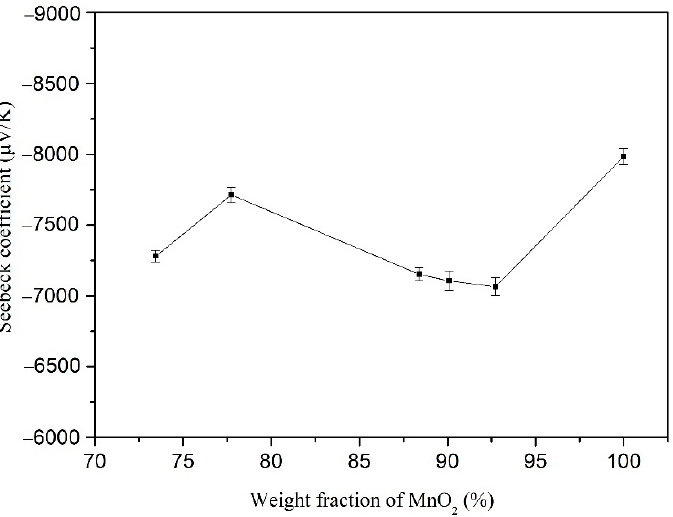
Figure 7. Seebeck coefficient of PANI/MnO 2 composite with different weight fractions of MnO 2 and pure MnO 2.